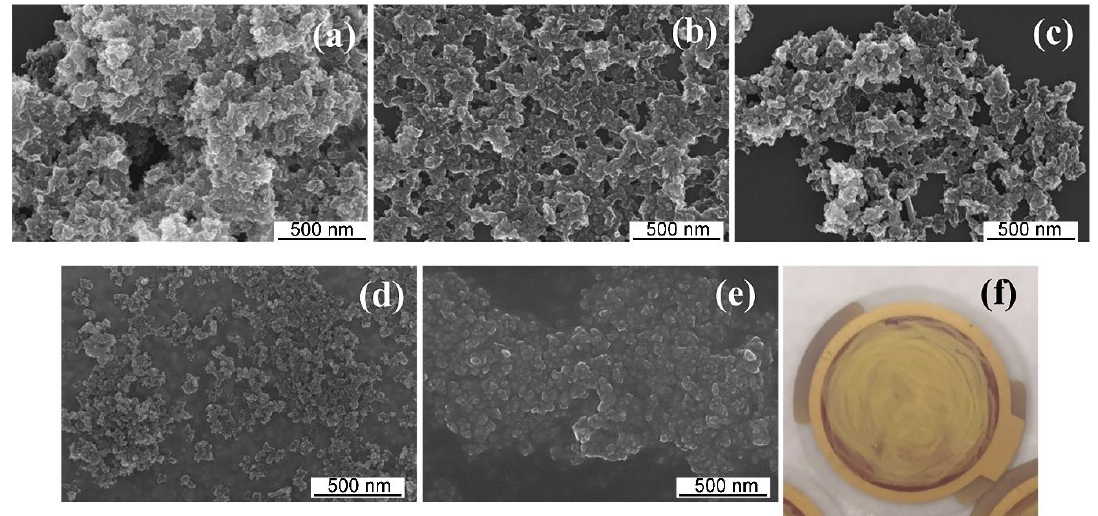
Figure 2. Scanning electron microscopy images of ( a ) the Fe 3 O 4 nanoparticles, ( b ) the molecularly imprinted polymers (MIPs), ( c ) the non-imprinted polymers (NIPs), ( d ) the MIPs-coated quartz crystal microbalance with dissipation monitoring (QCM-D) sensors, and ( e ) the NIPs-coated QCM-D sensors, and ( f ) a photograph of the MIPs-coated QCM-D sensors.